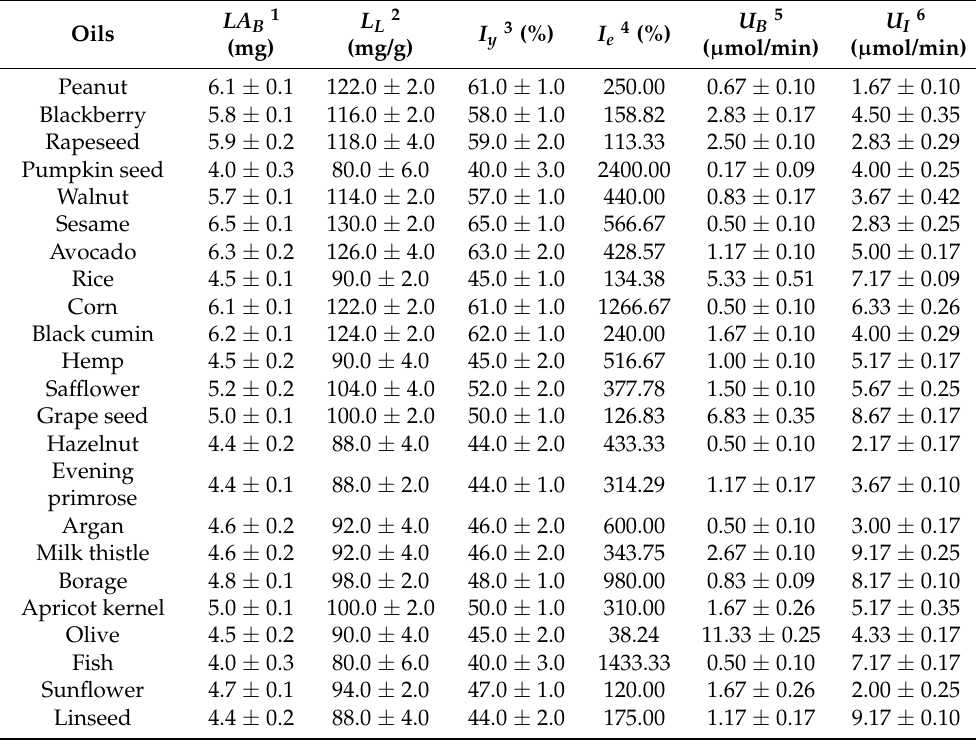
Table 2. AA-ANL lipolytic activity in free form and immobilized onto IB-150A support in 22 vegetable oils and fish